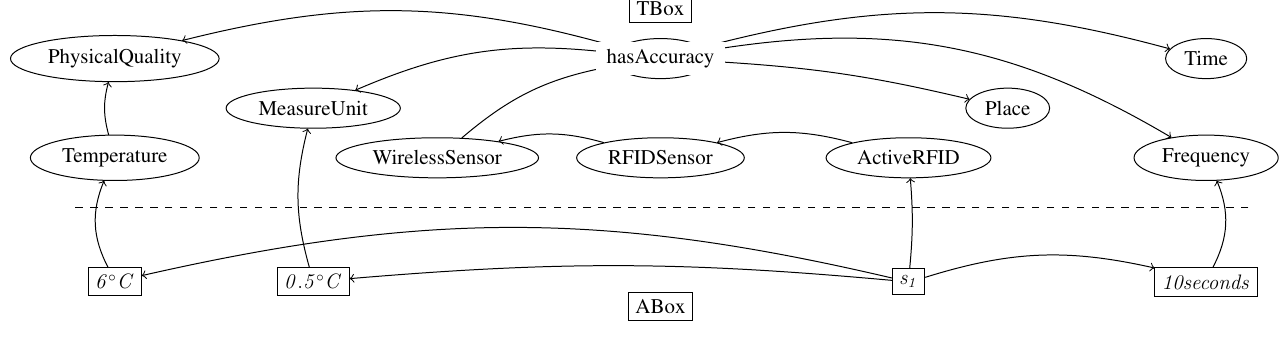
Figure 4. Graphical view of the sensor ontology.